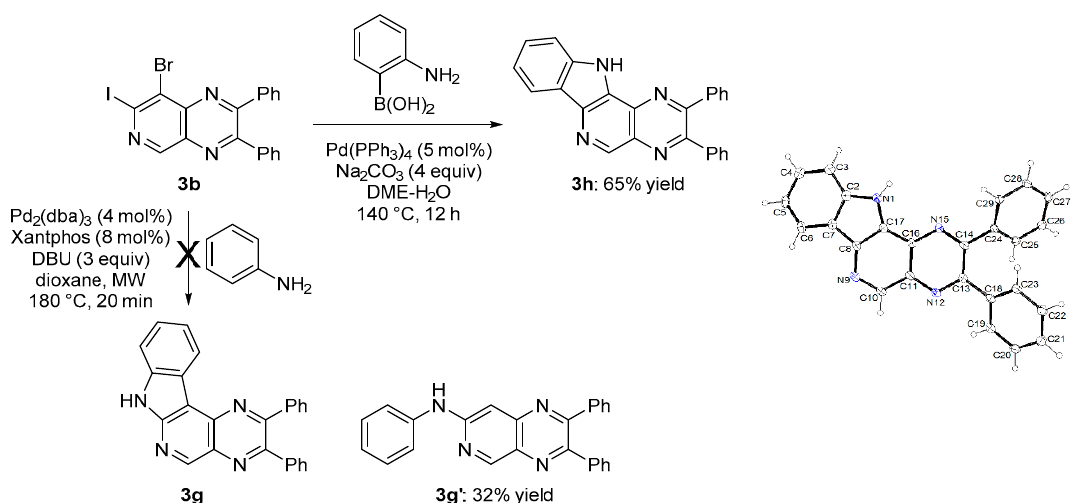
Scheme 3. Conversion of 8-bromo-7-iodo-2,3-diphenylpyrido[3,4- b ]pyrazine ( 3b ) into 2,3-diphenyl- 11 H -pyrazino[2 (cid:48) ,3 (cid:48) :4,5]pyrido[2,3- d ]indole ( 3h ) and ORTEP diagram (30% probability) of 3h .